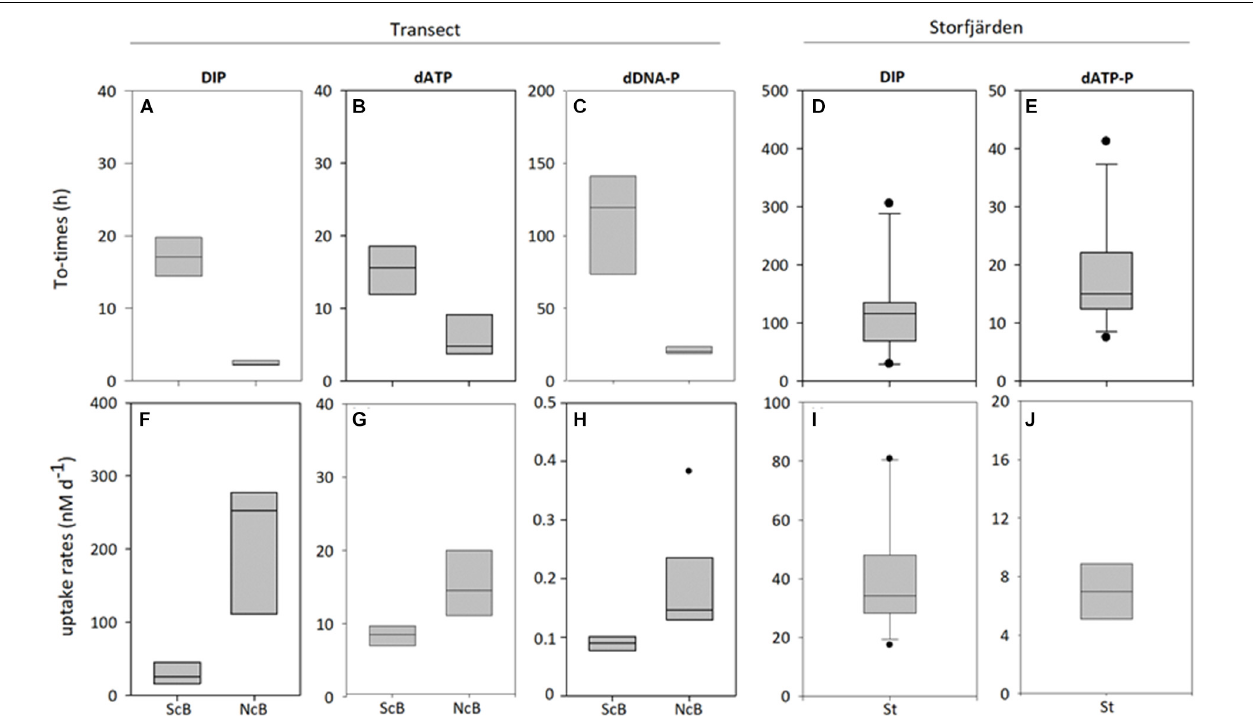
FIGURE 5 | Turnover times (A–E) and uptake rates (F–J) of DIP, dATP-P and dDNA-P at the two parts of the transect (southern part -ScB; northern part-NcB, and in the Storfjärden (St). The line inside the box represents the median value; the box is edged by the 25 and 75% percentile and the error bars indicate the 10 and 90%